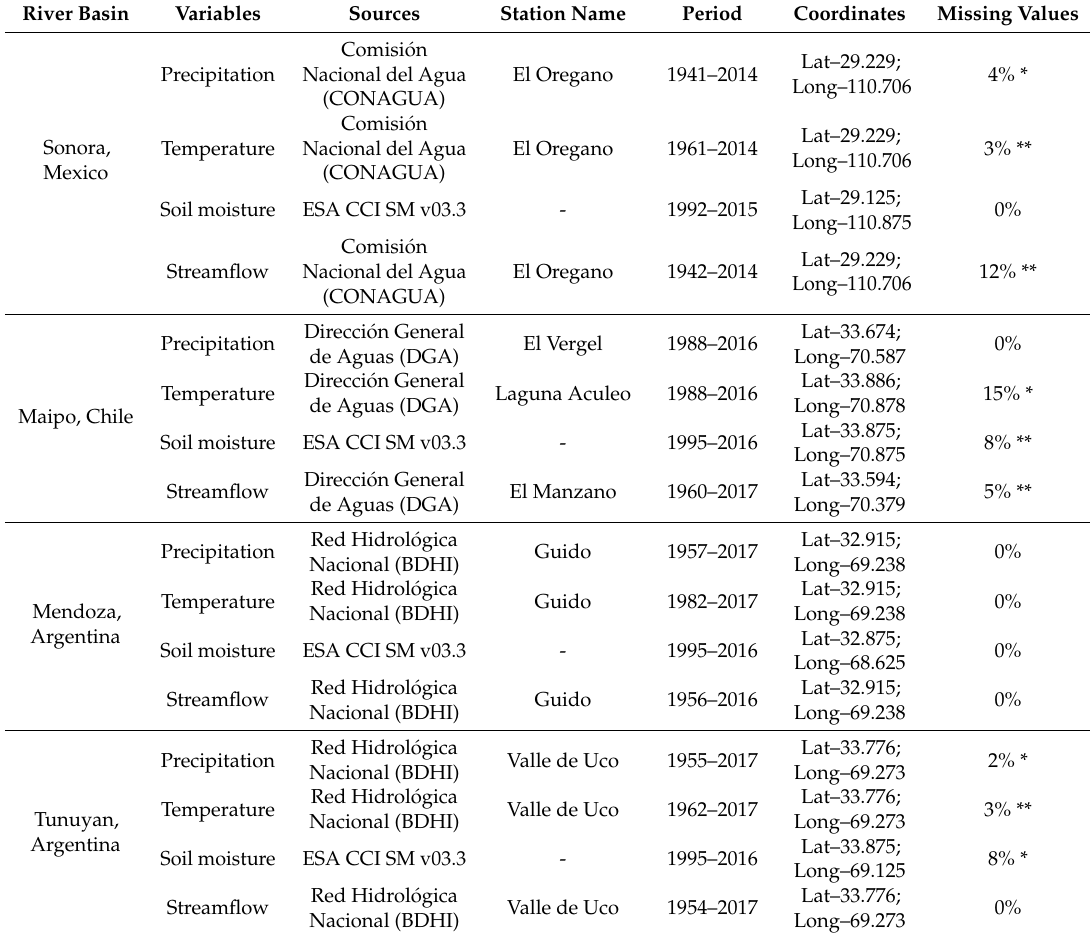
Table 1. Monthly input variables and their sources used in this study (filling methods are identified by * for linear regression and ** for linear